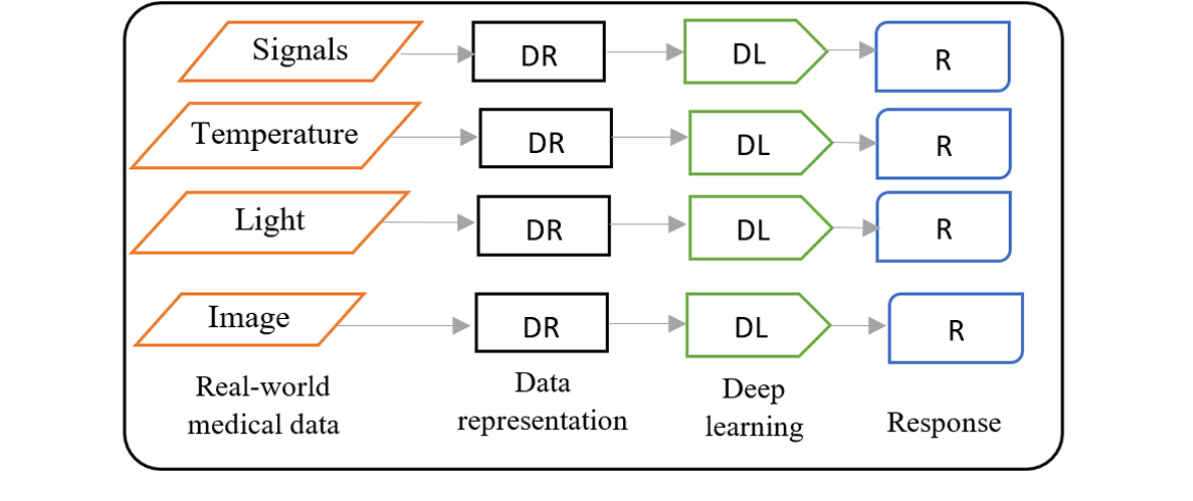
Figure 15. Current working technique for application of deep learning with biomedical data.